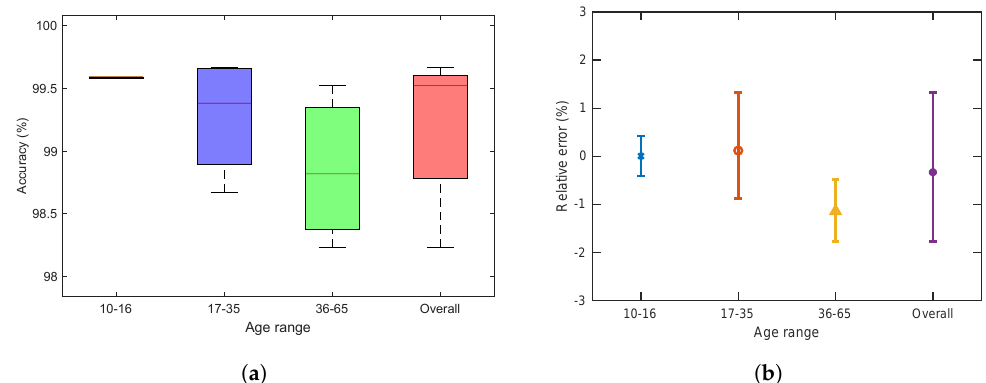
Figure 10. Accuracy and relative error for the instep girth measurement of different age groups after applying linear regression: ( a ) accuracy; ( b ) mean and its standard error (error bar) of relative difference (%) between MM and